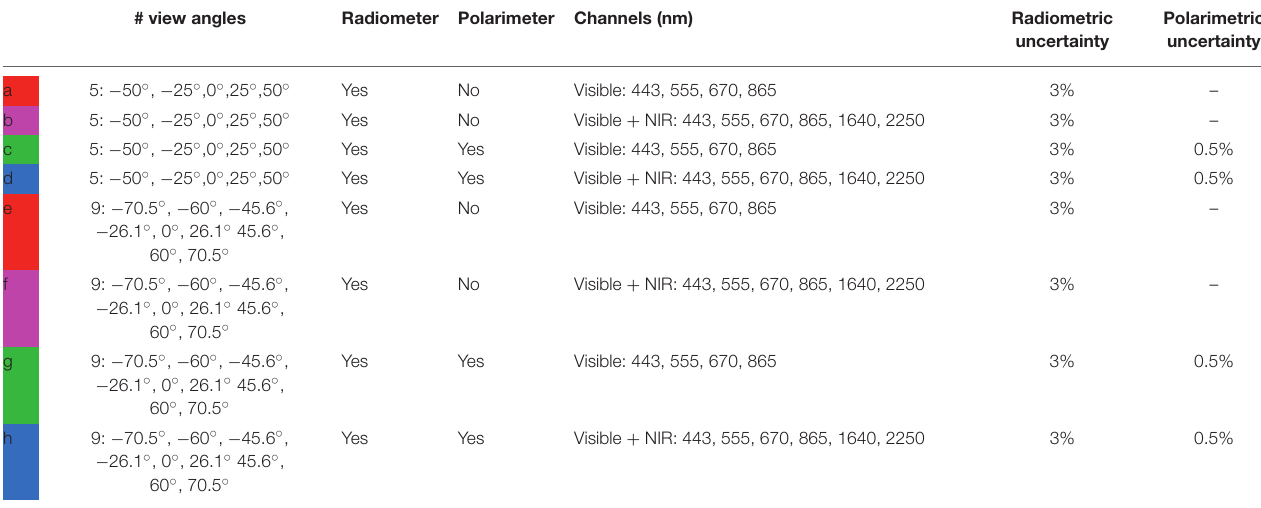
TABLE 2 | Prototype MAP characteristics.